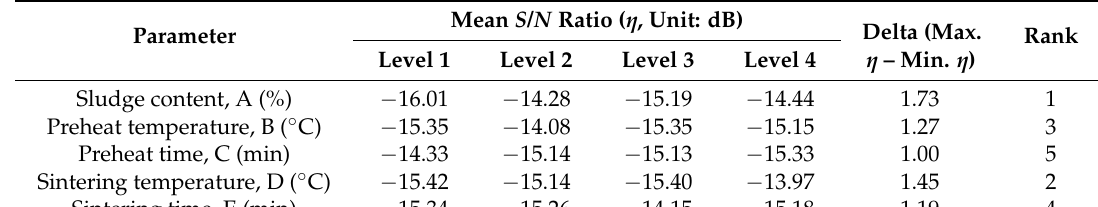
Table 12. S / N response table for loss on ignition.